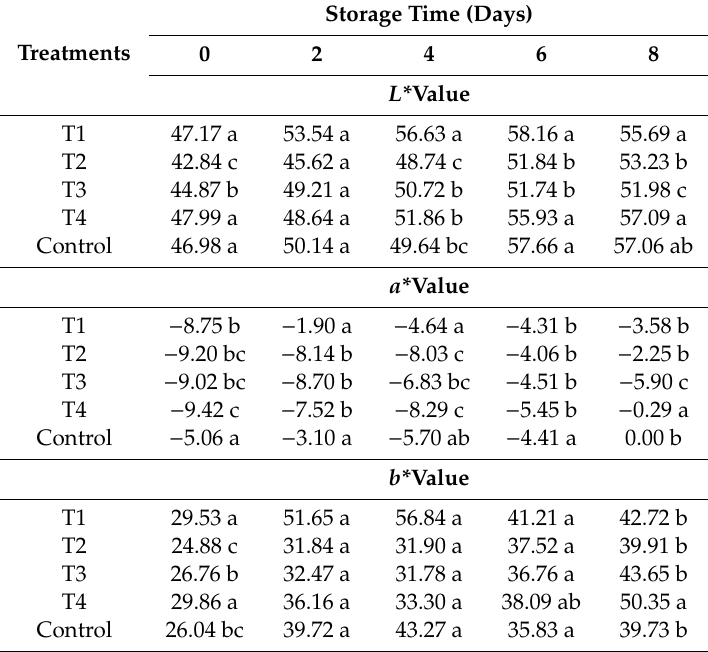
Table 2. Peel colour of ‘Maradol’ papayas stored at 30 ± 2 ◦ C and an RH of 80 ± 5%. L* (lightness), a* (hue angle green–red), and b* (hue angle